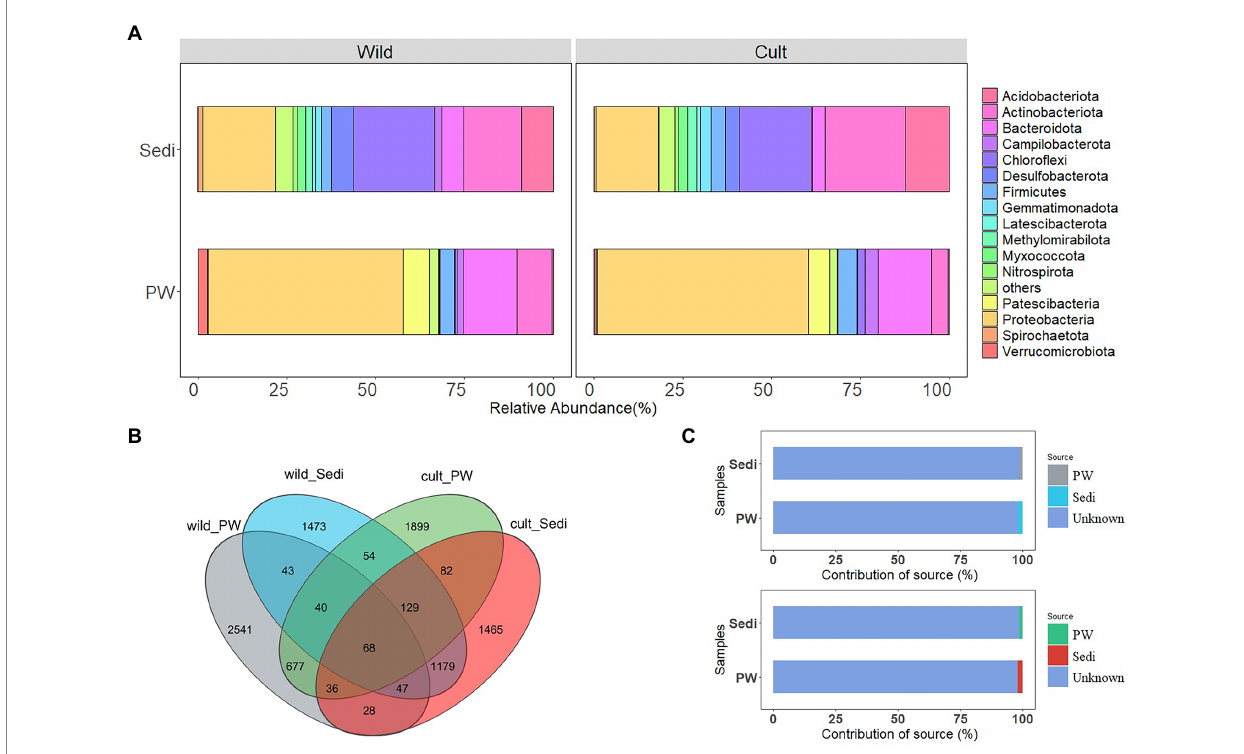
FIGURE 1 Variations in all bacterial alpha (A) , Venn diagram represents the number of ASVs detected (B) and contribution of the source to bacterial communities by the Source Tracker (C) in the pore water and sediment samples from the wild and cultivated Phragmites australis